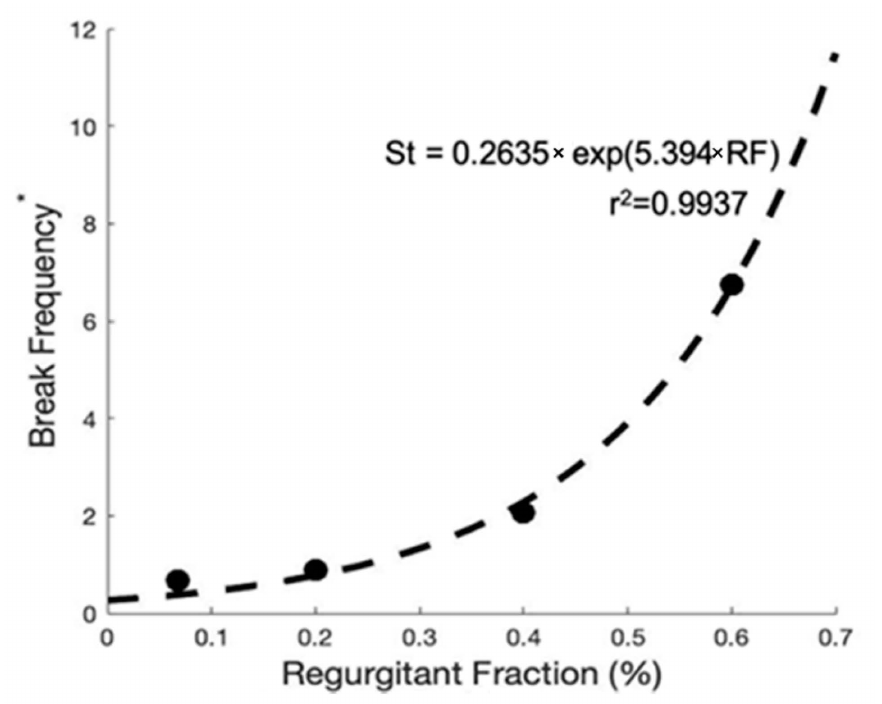
Figure 10. Correlation plot between non-dimensional break frequency and regurgitant